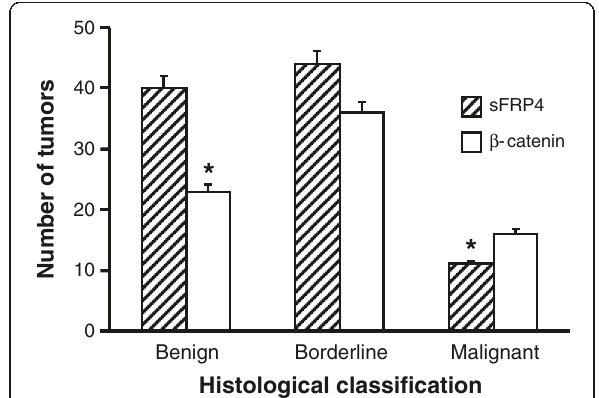
Figure 9 Graphical representation of the quantified proportion of tumours expressing sFRP4 and β -catenin based on histological classification of mucinous tumours as benign, borderline and adenocarcinomas. Values represent the mean for each group ± SEM. (* p <